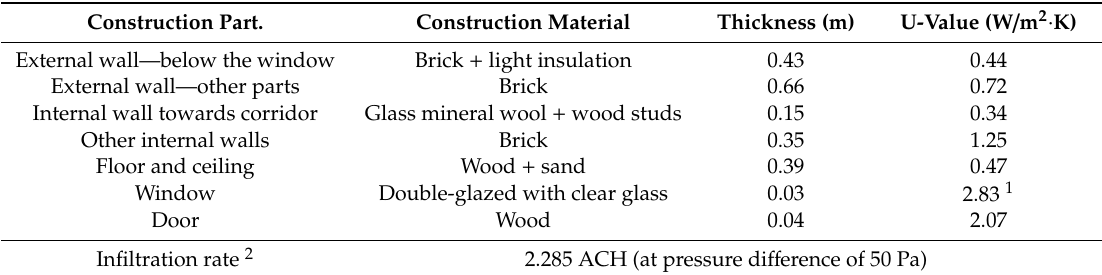
Table 3. Construction materials [24] and infiltration rate used in the IDA-ICE model of the selected room for the calibration purpose.